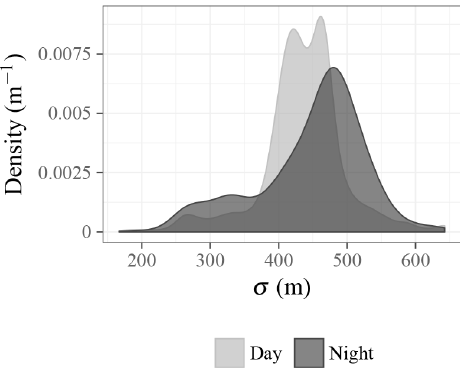
Figure 12. Distribution of predicted z uncertainty σ .